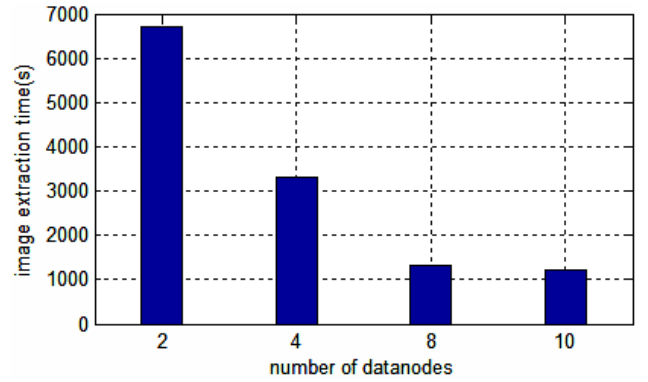
Figure 5. Comparision of the different number of datanodes used in